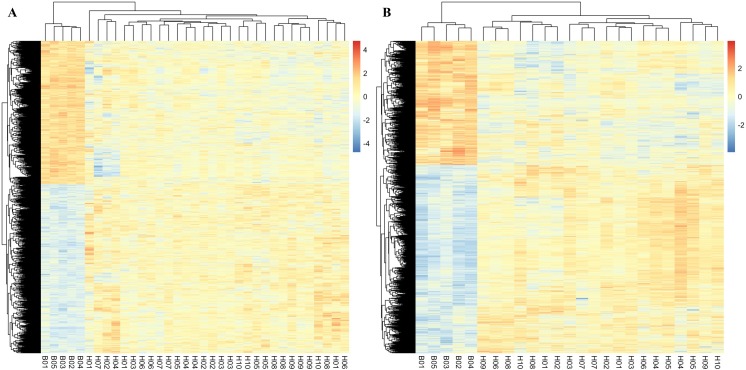
Parallel responses of adaptive genes across replicates.Normalized expression of significant genes identified in males (A) and females (B). The heat color indicates the expression of each gene in each sample. Comparing ancestral samples (B01–B05) to each of the evolved samples (H01–H10), 91% and 87% of the candidate genes in males and females change their expression to the same direction in all replicates, respectively.